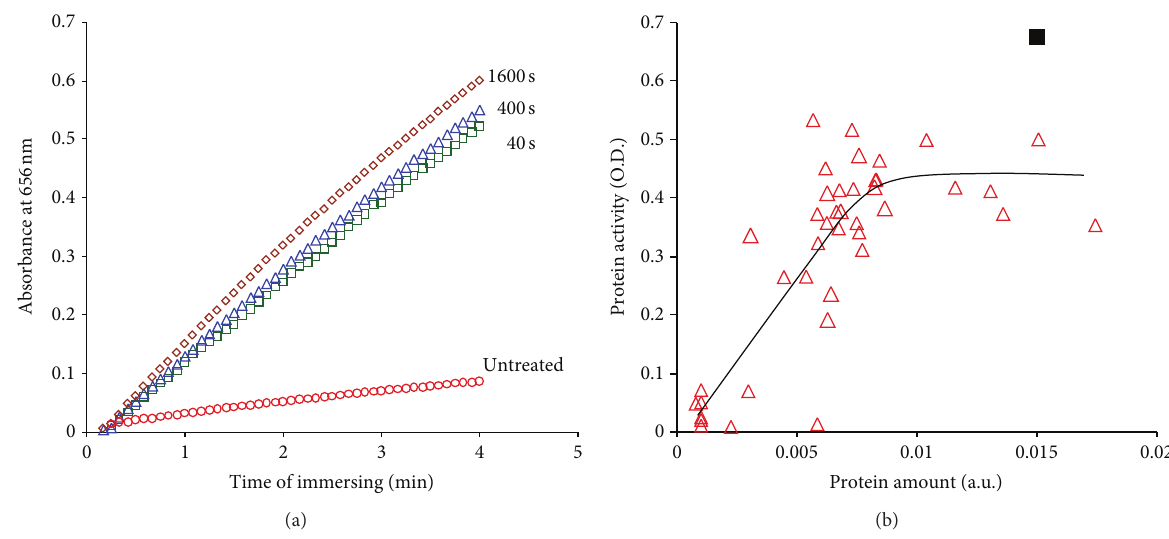
F 16: (a) Absorbance of TMB solution in dependence on the immersing time of UHMWPE surface with attached HRP. e curves of various PIII treatment time and the curve for untreated polyethylene are marked. (b) Catalytic activity of attached HRP on PIII-treated polyethylene in dependence of protein amount determined by FTIR ATR spectra. Full square is activity of HRP in solution with the concentration proportional to a complete monolayer of the protein on the surface.